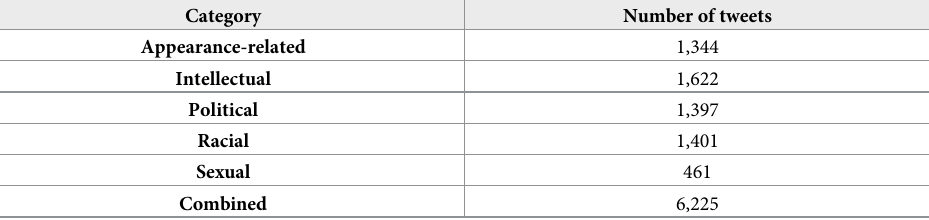
Table 6. Size of the training datasets for each